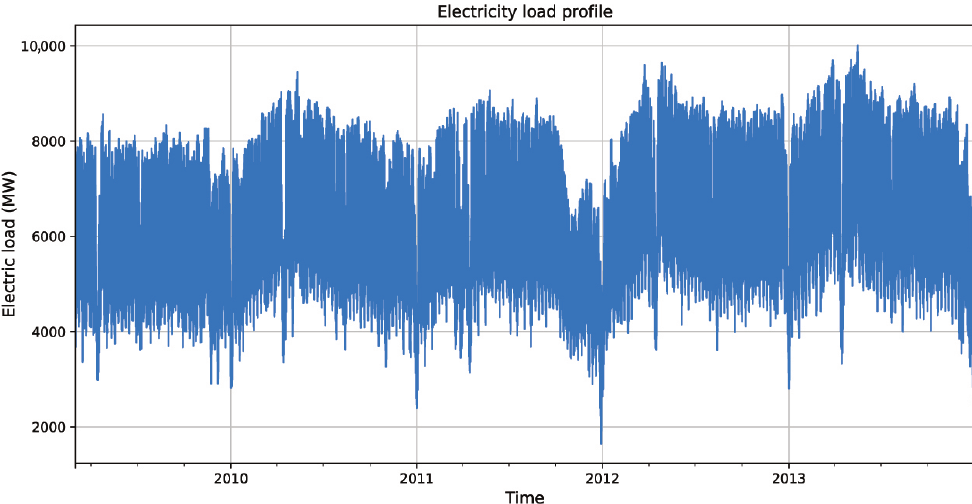
Figure 4. Half-hourly electricity load profile from 1 March 2009 to 31 December 2013.